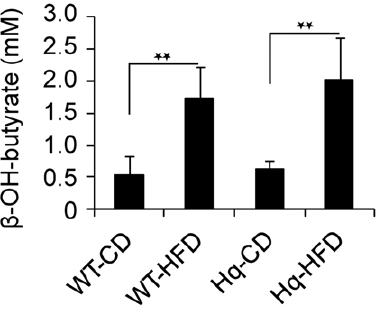
Figure 7. HFD-fed individuals exhibit a higher blood level of b - hydroxybutyrate than the CD-fed individuals. Blood level of b - hydroxybutyrate ( b -OH-butyrate) was determined at 6 months of age, after 24 hours of fasting in 5 CD-fed WT mice, 5 HFD-fed WT mice, 10 CD-fed Hq mice and 10 HFD-fed Hq mice. **: p , 0.01 (Student’s two- tailed t test).